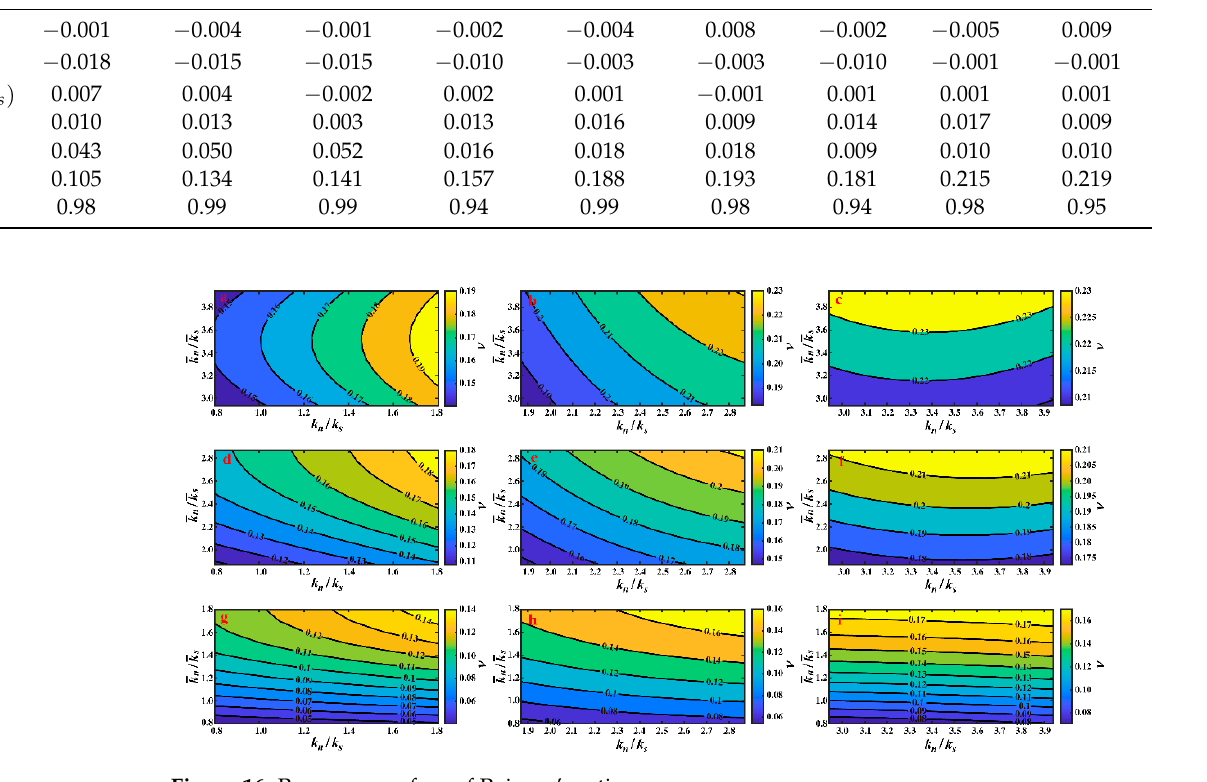
Figure 16. Response surface of Poisson’s ratio.